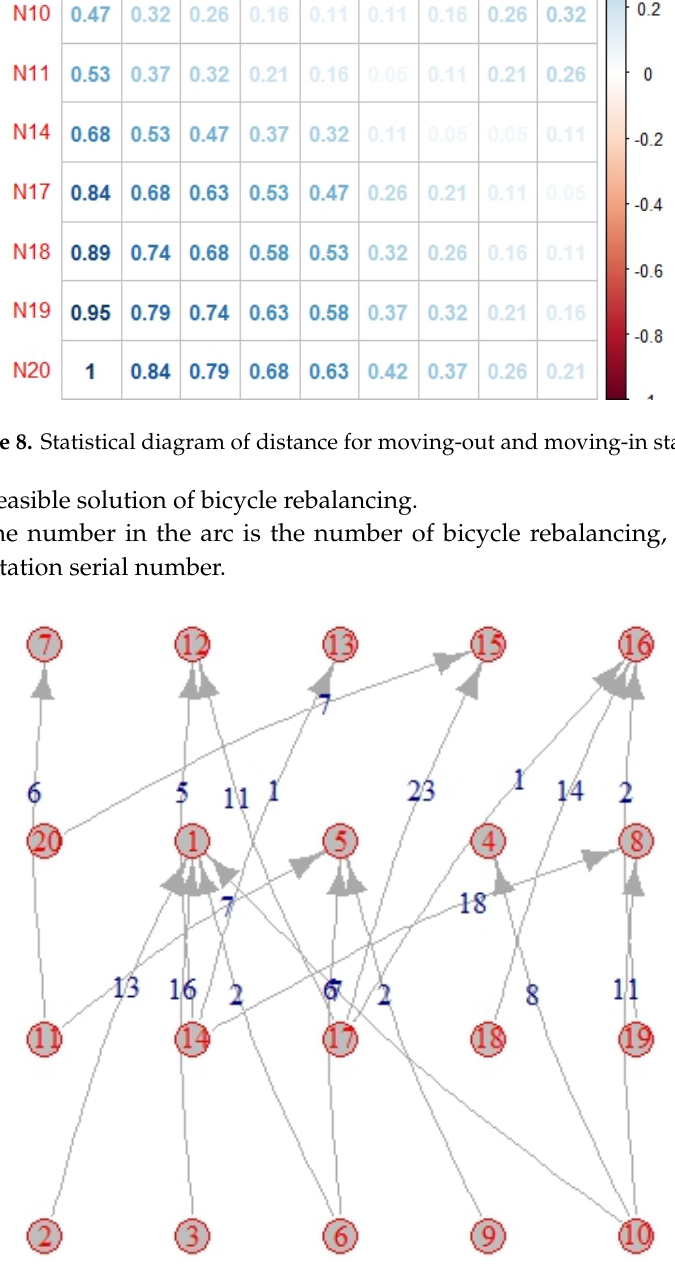
Figure 9. Rebalancing chart of the moving-out stations and moving-in stations.